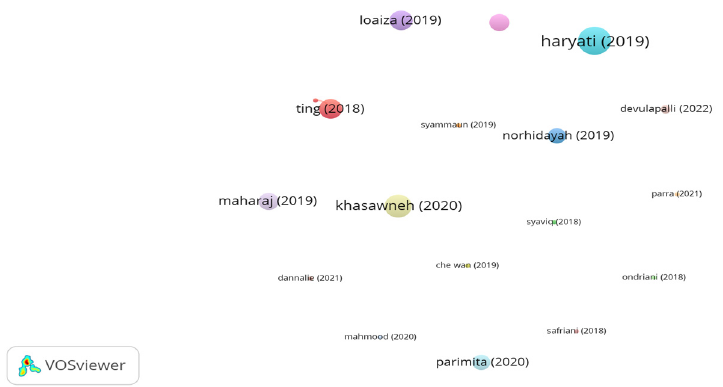
Figure 15. Network visualization of coconut fibers.